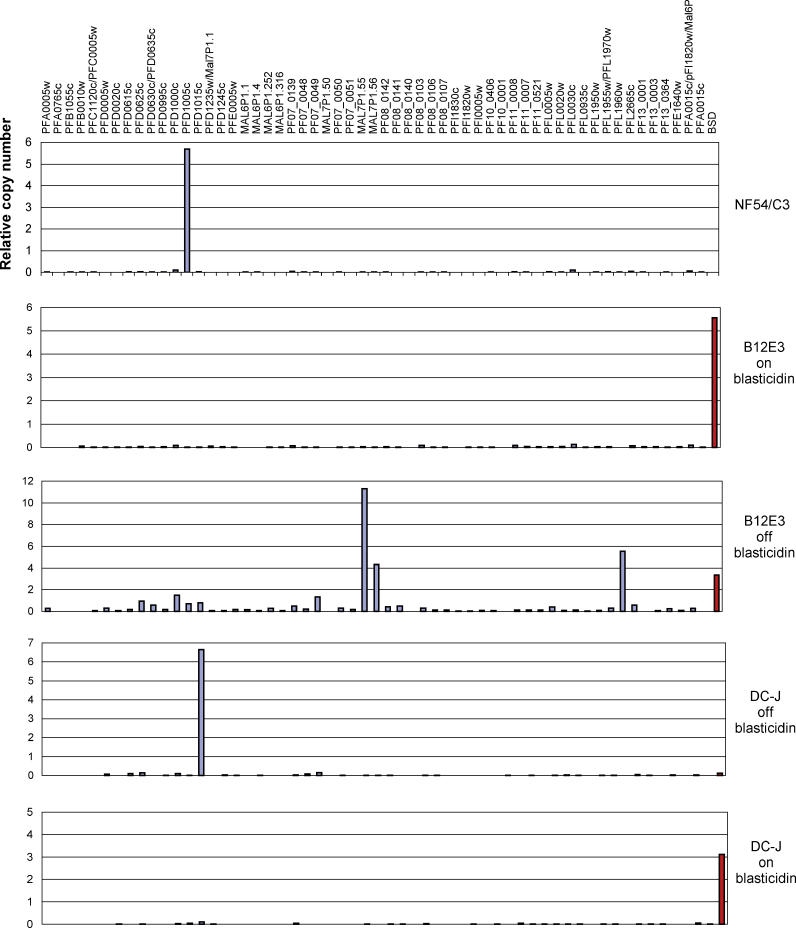
Analysis of Levels of Transcription of the Entire var FamilyAll values are presented as relative copy number to the housekeeping gene seryl-tRNA synthetase (PF07_0073).Top panel: NF54 parasites were cloned by limiting dilution, and var gene expression was measured by Q-RT-PCR as soon as the culture reached the required parasitemia, approximately 6 wk after plating. The clone NF54/C3, which was used to generate all transgenic lines, was predominantly expressing var PFD1005c (located on Chromosome 4 internal cluster) while expression of the rest of the var family was virtually undetectable.Second panel: The recombinant line B12E3 growing under blasticidin pressure only transcribed bsd (red), while transcription levels of the rest of the var family was close to zero (blue).Central panel: Expression of additional var genes was easily observed after the parasites were grown for 10 wk without drug pressure. At this point the culture is transcriptionally heterogeneous and bsd is no longer the dominant gene. Five genes were expressed at levels equal to or greater than the control (copy number = 1).Fourth panel: The transcription pattern of clone DC-J that was re-cloned from this culture represents a population that had switched away from bsd and now predominantly expresses var PFD1015c. Applying blasticidin to DC-J resulted in the selection of parasites that had switched back to exclusively expressing bsd (bottom panel).